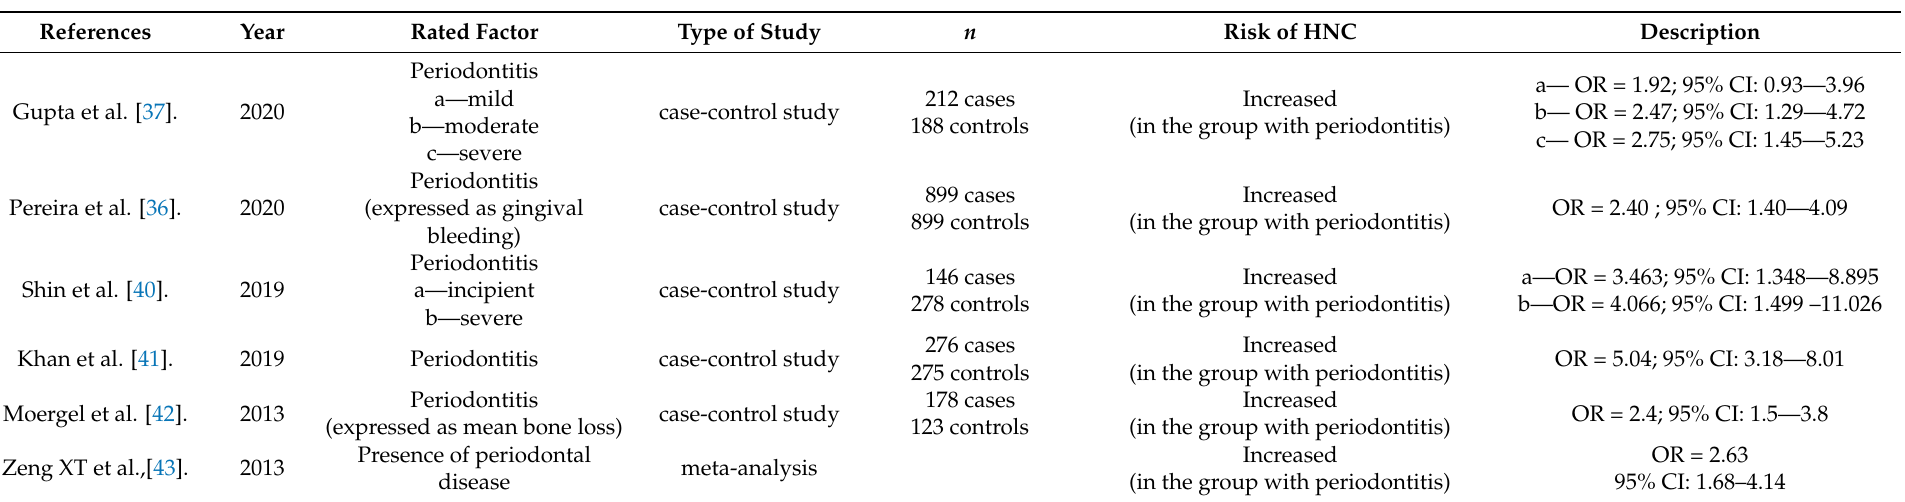
Table 3. The impact of occurrence of periodontal disease on risk of developing head and neck squamous cell